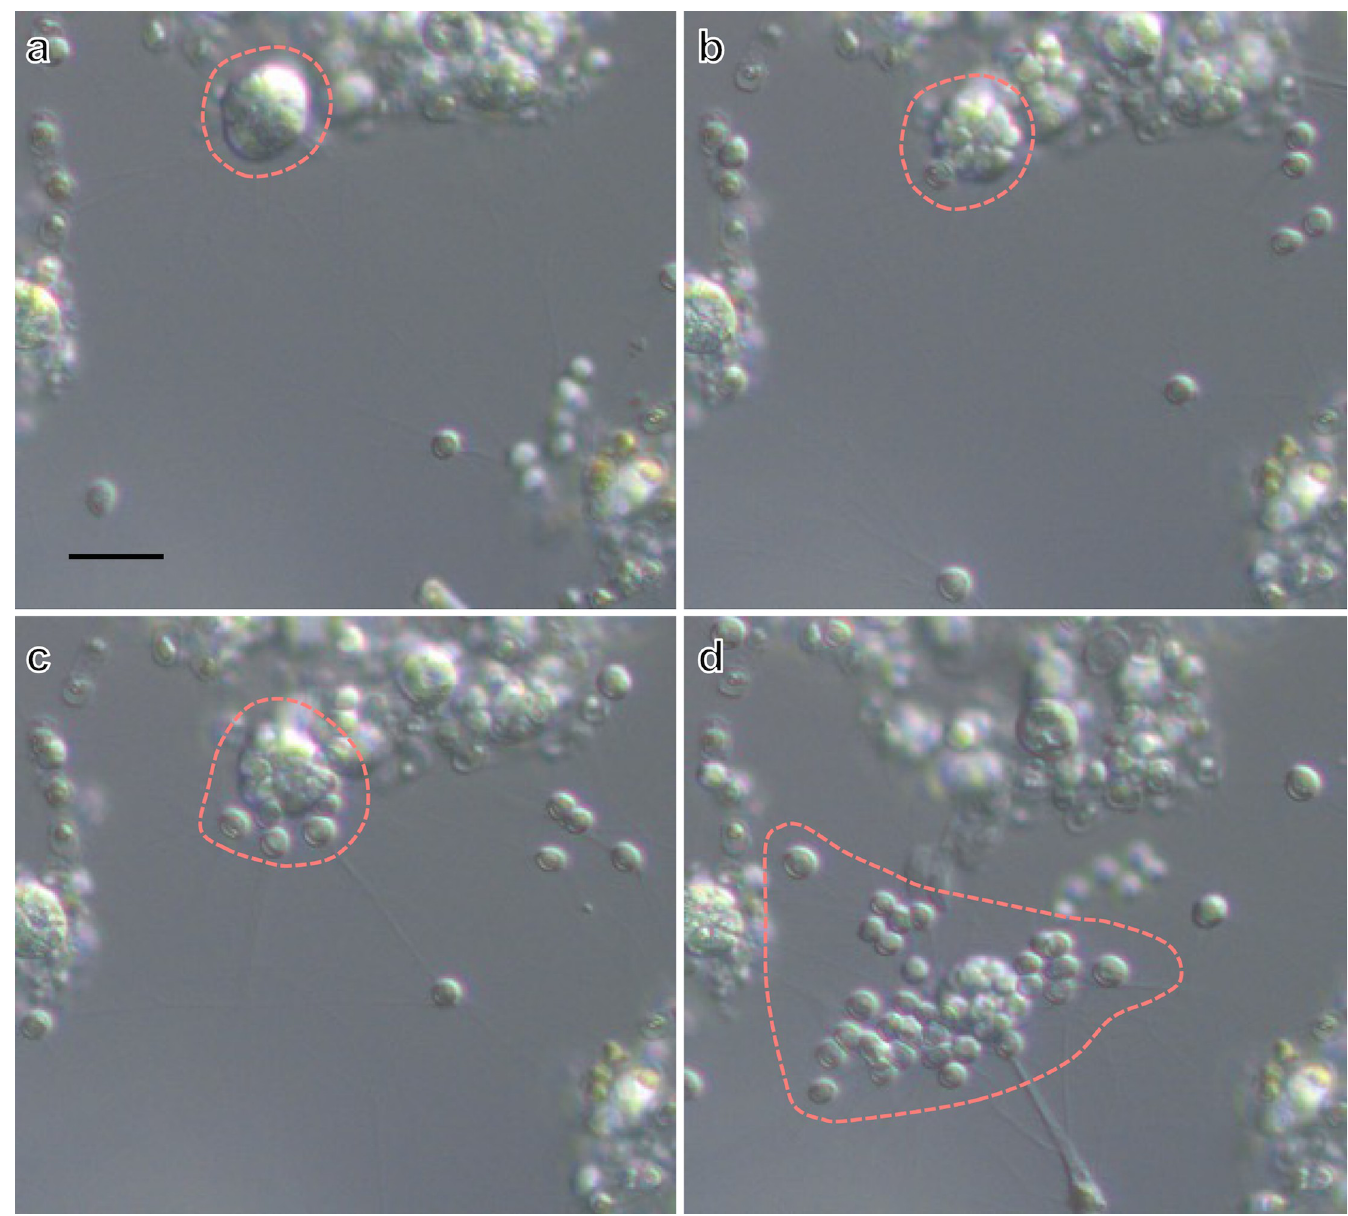
Fig 4. Continuous observation of aplanospore formation. (a) Immature zoosporangium of Aplanochytrium (SEK 717), 0 min. (b) Mature sporangium showing cleavage of protoplasm, 28 min. (c) Beginning of aplanospores release, 31 min. (d) Completely released ca. 30 aplanospores, 39 min. Scale bar = 10 μ m. These continuous observation images can be viewed as a time-lapse video movie (S4